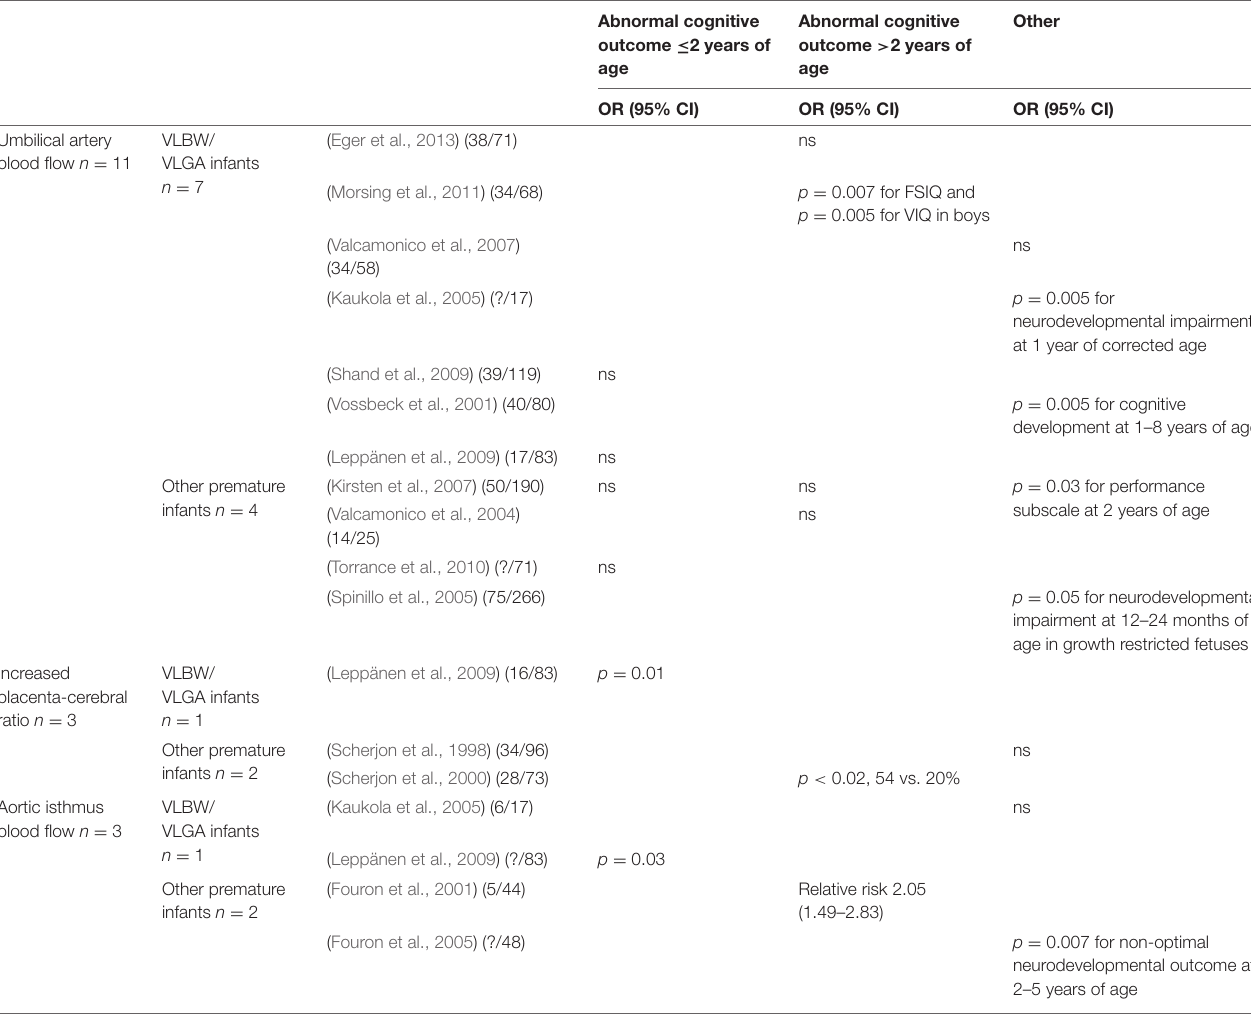
TABLE 2 | The outcomes of the 15 included articles divided according to the placental or fetal blood flow measurements used (umbilical artery blood flow, increased placenta-cerebral ratio, retrograde flow in the aortic isthmus) and developmental outcomes (abnormal cognitive outcome ≤ / > 2 years of age or other).